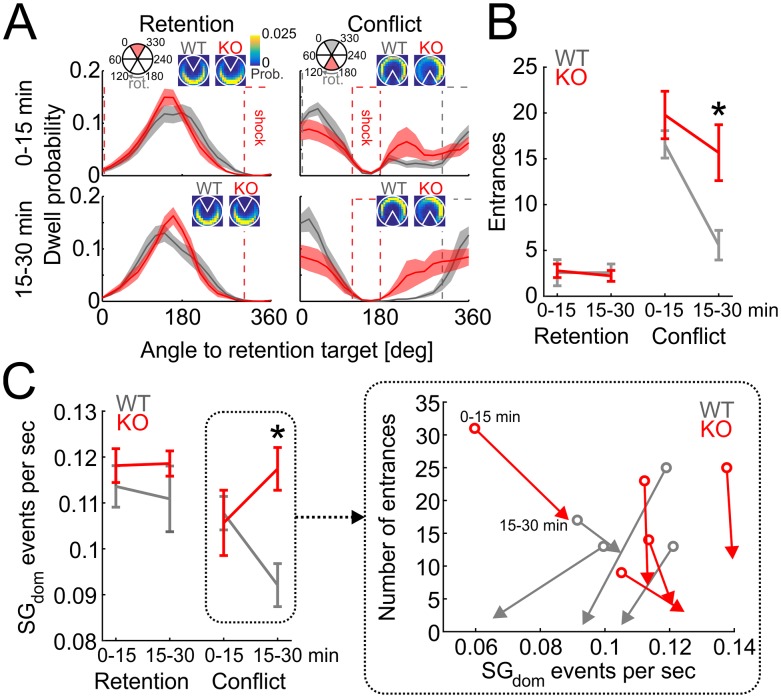
Cognitive inflexibility and associated increases of SG dominance in Fmr1-KO mice.(A) Dwell distribution during first half (0–15 min; top) and second half (15–30 min; bottom) of retention (left) and conflict (right) sessions for WT (gray) and Fmr1-KO (red) mice. Dotted lines show locations of the active shock zone during each session (red) and location of the initial shock zone during conflict sessions (gray). Insets show dwell probability distributions. (B) Behavioral performance during retention and conflict sessions for WT and Fmr1-KO mice. (C) Rates of SGdom events during retention and conflict sessions. *p < 0.05 between genotypes. Data represent average ± SEM. Inset: vectors showing the time evolution from the first half (circles, 0–15 min) to the second half (arrowheads, 15–30 min) of the conflict session in the coordinate system of x = SGdom rate and y = number of entrances. KO, knockout; rot., rotation; SG, slow gamma; WT, wild-type. Underlying data can be found here: [https://goo.gl/oHH22A].